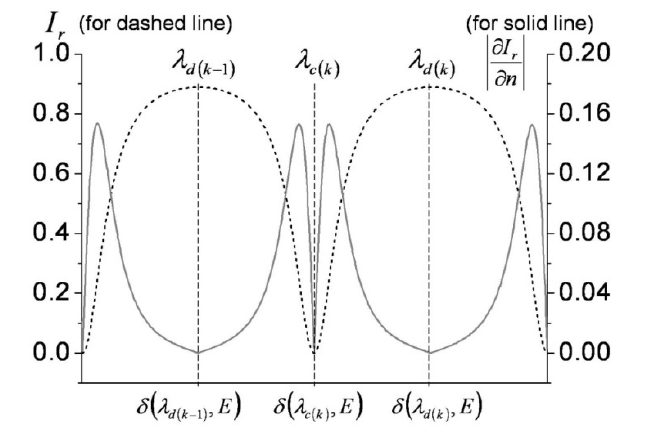
Figure 7. Reflectance (dashed line) and its change (solid line) for type IV probe for a 0.01% modulation of n , with two interference fringes shown). (Here, r 12 = r 22 = 0.5; C = e